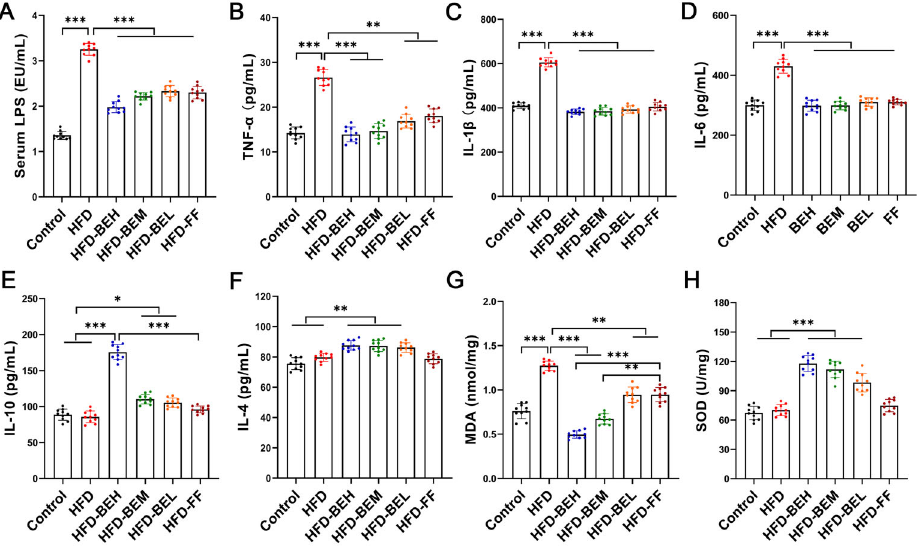
Figure 6. Berberine and evodiamine (BE) at high, medium, and low doses (BEH, BEM, BEL) or feno fi brate (FF) treatment alters in fl ammatory cytokine expressions and inhibits oxidative stress of animals fed a high-fat diet (HFD). A , Lipopolysaccharide (LPS), ( B ) tumor necrosis factor (TNF- a ), ( C ) interleukin (IL) 1 b , ( D ) IL-6, ( E ) IL-10, and ( F ) IL-4 cytokines levels, ( G ) malondialdehyde (MDA) content, and ( H ) superoxide dismutase (SOD) activity were evaluated by enzyme-linked immunosorbent assay (ELISA). Data are reported as means ± SD. *P o 0.05, **P o 0.01; ***P o 0.001 (one-way ANOVA).